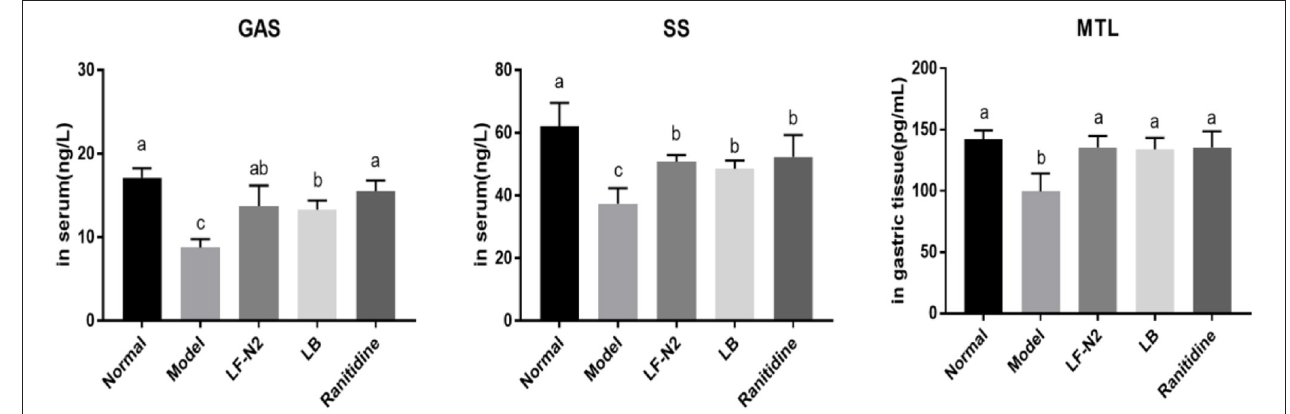
FIGURE 4 | Levels of GAS, SS and MTL in serum and gastric tissue, ( n = 6). LF-N2, Lactobacillus fermentum TKSN02 (1 × 10 9 CFU//kg); LB, Lactobacillus bulgaricus (1 × 10 9 CFU/kg); ranitidine (200 µ g/g). a − c Mean values with different letters in the same bars are significantly different ( P < 0.05).